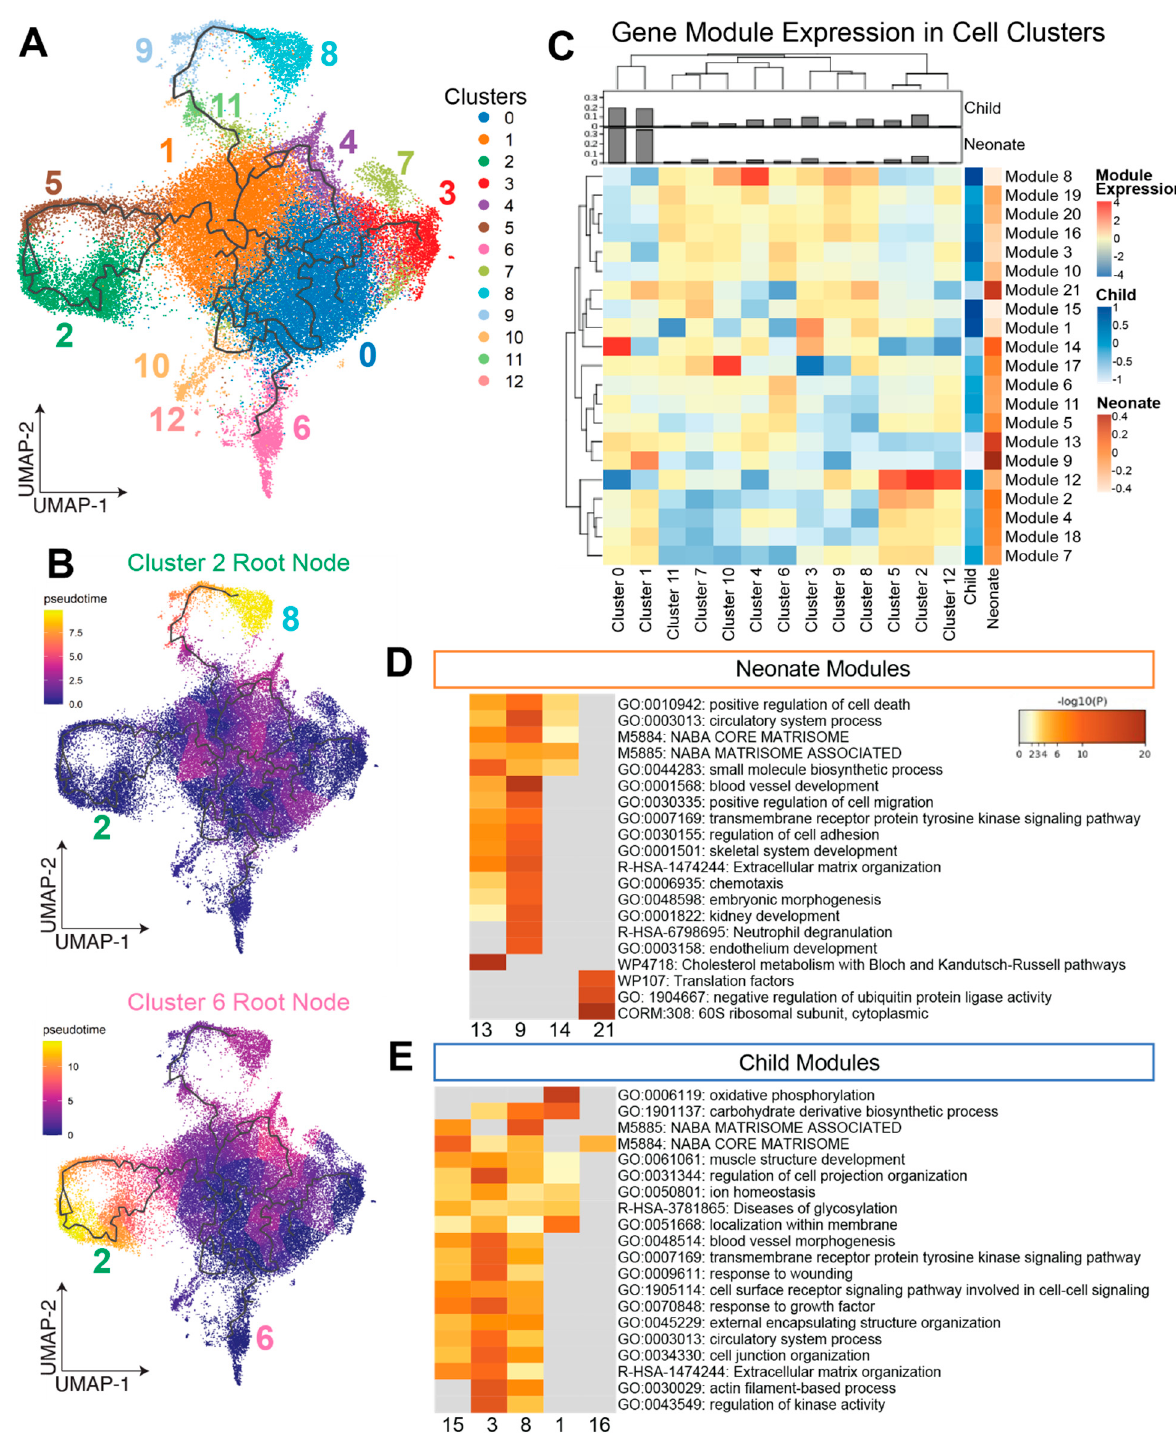
Figure 2. Trajectory analysis and gene clustering. UMAP projections with trajectories determined by Monocle colored by ( A ) monocle clusters and ( B ) pseudotime with root nodes set to cluster 2 (top) and cluster 6 (bottom) from the Seurat analysis. ( C ) gene module expression heatmap by Seurat cluster. Modules were determined through a Leiden clustering of highly co-expressed genes along trajectories. Module expression levels are computed by age group and are shown in the two rightmost columns in the heatmap. Cluster proportions by age group are illustrated by bar charts on top of the heatmap. Pathway analysis for the highest expressing modules among ( D ) neonates and ( E ) children highlights important biological differences between the age groups.